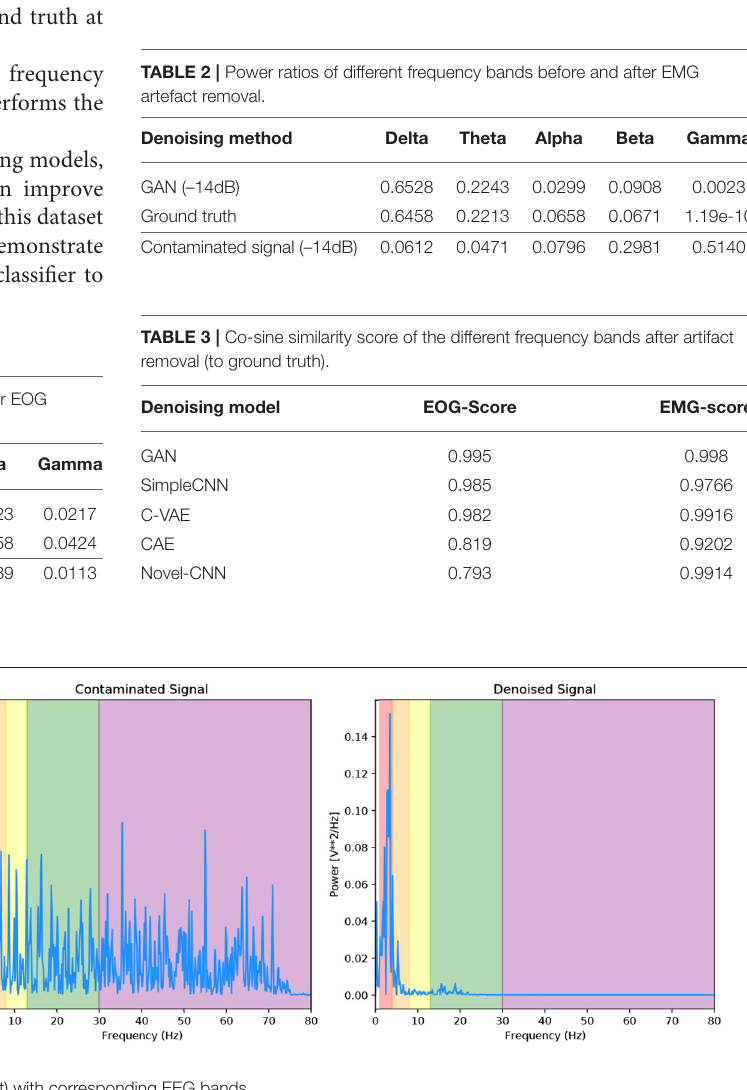
Frontiers in Neuroergonomics |